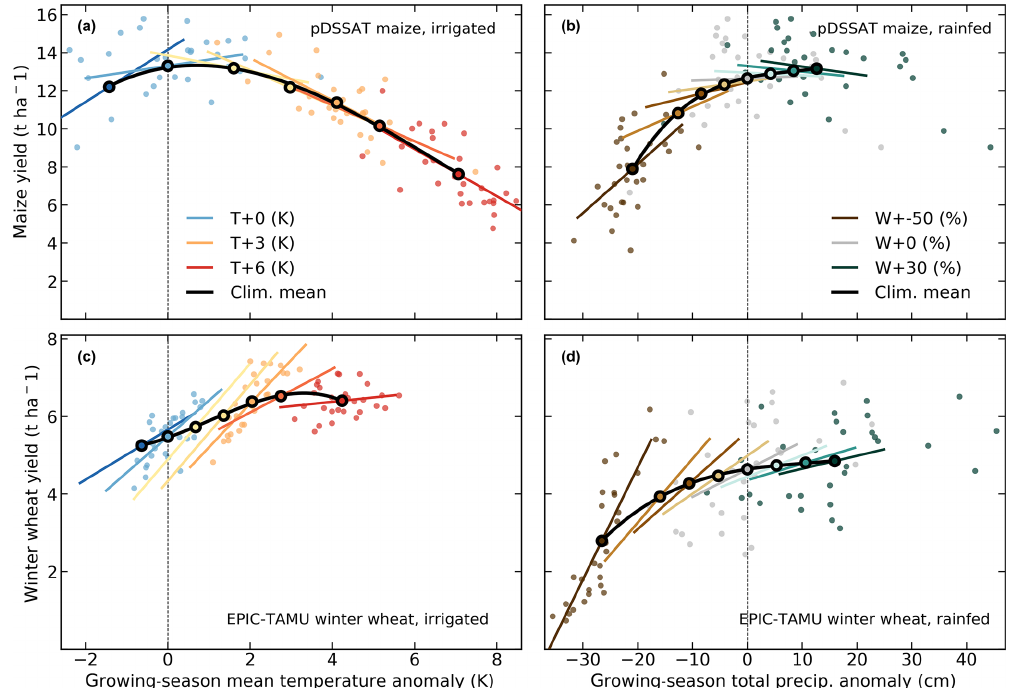
Figure 1. Example showing distinction between crop-yield responses to year-to-year and climatological-mean shifts in climate variables, showing representative high-yield regions for maize in pDSSAT (northern Iowa, a , b ) and winter wheat in EPIC-TAMU (France, c , d ). Left column (a, c) shows irrigated crops, with all temperature cases with other variables held at baseline values, and right column (b, d) shows rainfed crops, with all precipitation cases. Figure shows A0 output, in which growing seasons shift under future climate, so local growing-season temperature changes can differ from prescribed uniform offsets: for example, a 6K applied uniform warming results in a growing-season temperature warmer by ∼ 7K for maize in Iowa (b) but by less than 6K for wheat in France (d) . Open black circles mark climatological-mean yields and bold black lines show a third-order polynomial fit through them. Colored lines show linear regressions (by orthogonal distance regression) through the 30 annual yields of each parameter case. Colored circles show annual yields for selected cases. Differences in slopes of colored and black lines mean that responses to year-to-year fluctuations differ from those to longer-term climate shifts. Differences are generally stronger for wheat (c, d) than maize (a, b) . Note that for rainfed crops, slope differences in this representation could also result from correlated precipitation and temperature fluctuations in the baseline time series, but P – T correlations do not contribute to the effects shown here. Such correlations would complicate emulations based on year-to-year yields but would not necessarily bias